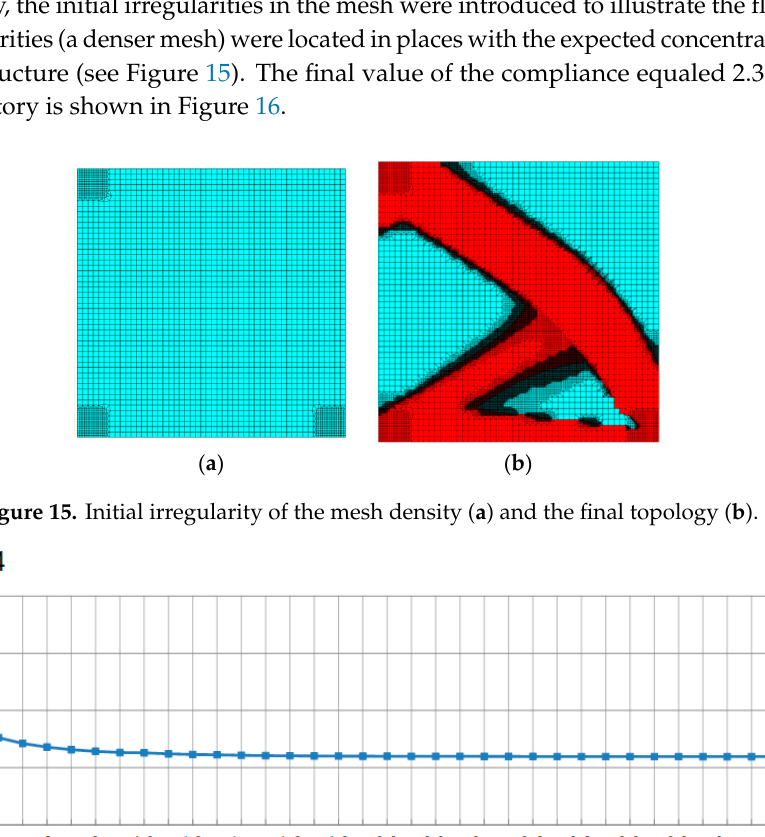
Figure 14. Final topology obtained using [37] with a small ( a ) and a large ( b ) filtering radius.